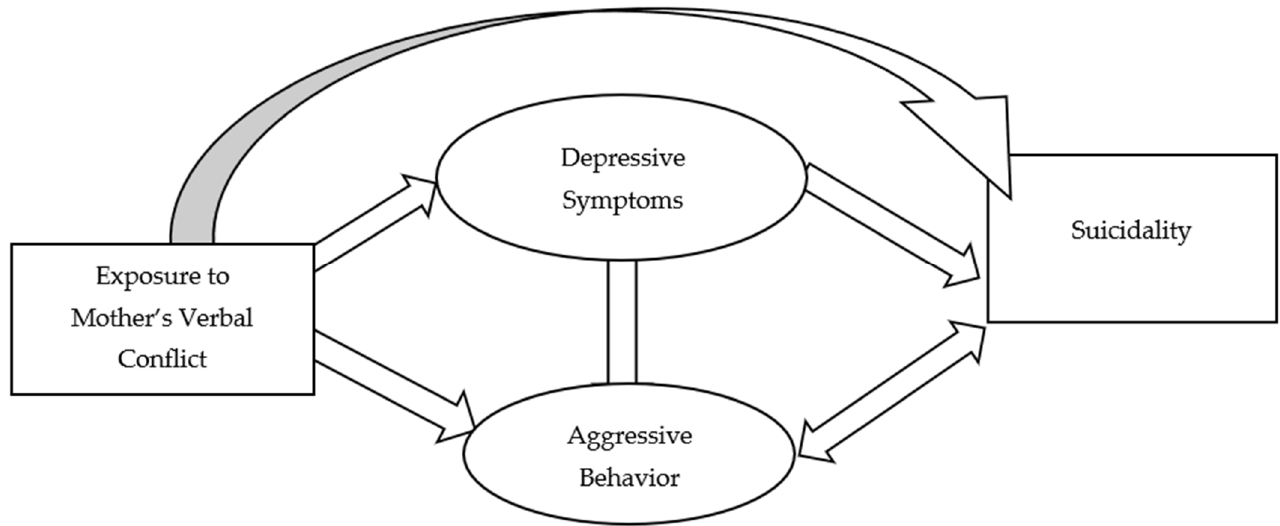
Figure 1. Conceptual framework.